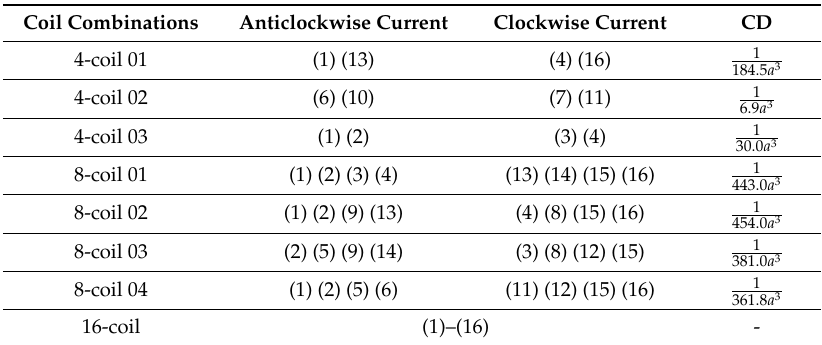
Figure 4. Sketch maps of different coil combinations based on the 16-coil array. Current directions are indicated by arrows. Coils with clockwise or anticlockwise current are regarded as stimulating coils, whereas the gray ones represent coils without electricity. “a” indicates the length between two adjacent coils and the connecting lines in each coil array mark out the specific areas corresponding to different energized coil combinations. Table 1. Coil combinations of 4-coil group and 8-coil group. “a” indicates the distance between adjacent coils in a row, showing values of compact degree (CD)